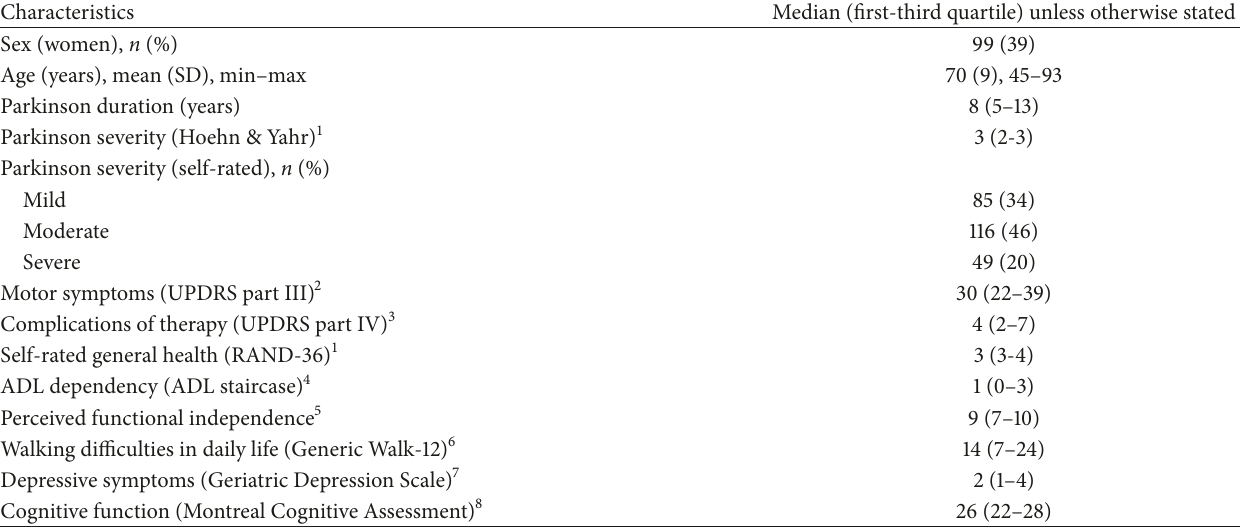
Table 1: Participants’ characteristics ( n = 243–251, depending on missing